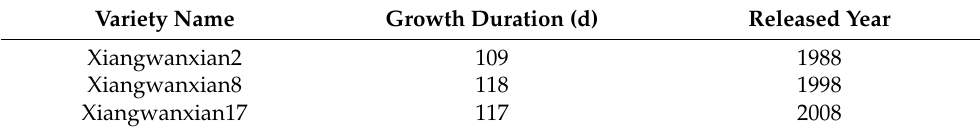
Table 1. The detailed information for the tested